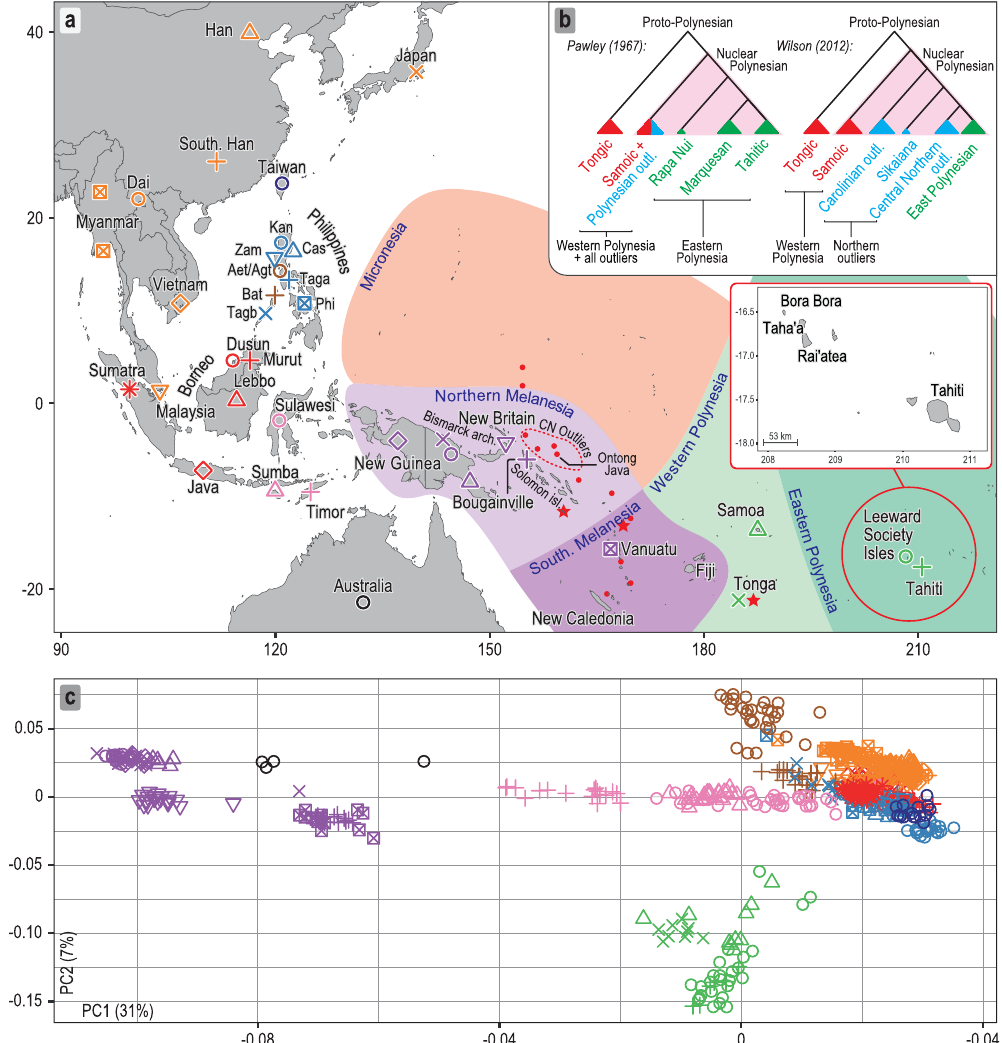
Figure 1. Sampling locations and overview of genomic diversity. ( a ) Sources of population data used in the present study. The Philippine group names are abbreviated as follows: Aet (Aeta); Agt (Agta); Bat (Batak); Cas (Casiguran); Kan (Kankanaey); Taga (Tagalog); Tagb (Tagbanua); Zam (Zambales); and Phi (Philippines, incorporating all other groups from this region). Colours indicate regional affiliation of populations used for analysis of autosomal DNA: orange – mainland Southeast Asia and East Asia; dark blue – Taiwan; brown – Philippines Aeta, Agta and Batak negritos; light blue – Philippines non-negritos; red – western Indonesia; pink – eastern Indonesia; purple – northern Melanesia and New Guinea; black – Australia; green –Polynesia. The usage of populations varies with the type of analysis employed (Supplementary Table S1). Inset map shows the three populations from the Leeward Society Isles, and Tahiti, the major island in the Windward Society Isles. The red circles within Micronesia and Melanesia represent 20 of the atolls and islands referred to collectively as outlier Polynesia. The red stars denote the three additional Polynesian outlier populations (Rennell and Bellona, Tikopia), which together with Tonga, were used in analysis of ancient admixture by Skoglund, et al . 25 . Detailed sample information is given in Supplementary Table S1. The map was created using R v. 3.4.1 (R Core Team (2017). R: A language and environment for statistical computing. R Foundation for Statistical Computing, https://www.R-project.org/), and packages ‘maps’ v. 3.2.0 (https://cran.r-project.org/ package = maps) and ‘mapdata’ v. 2.2-6 (https://cran.r-project.org/package = mapdata). ( b ) Inset at top right shows two alternative reconstructed sub-groupings of Polynesian languages discussed in the text. The critical differences are the position of the East Polynesian languages relative to the rest of nuclear Polynesian, and their relationship to the Central Northern Outlier languages. In the sub-grouping according to Pawley 31 all the Polynesian Outlier languages group within Samoic implying an early separation of Proto-East Polynesian from the rest of the Nuclear Polynesian languages. In the alternative sub-grouping proposed by Wilson 32 the Central Northern Outlier languages group with the languages of East Polynesia, within a larger clade containing the other Northern Outlier languages. ( c ) Principal components analysis of genome-wide SNP diversity in 639 individuals populations shown in panel A; axes are scaled by the proportion of variance described by the corresponding principal